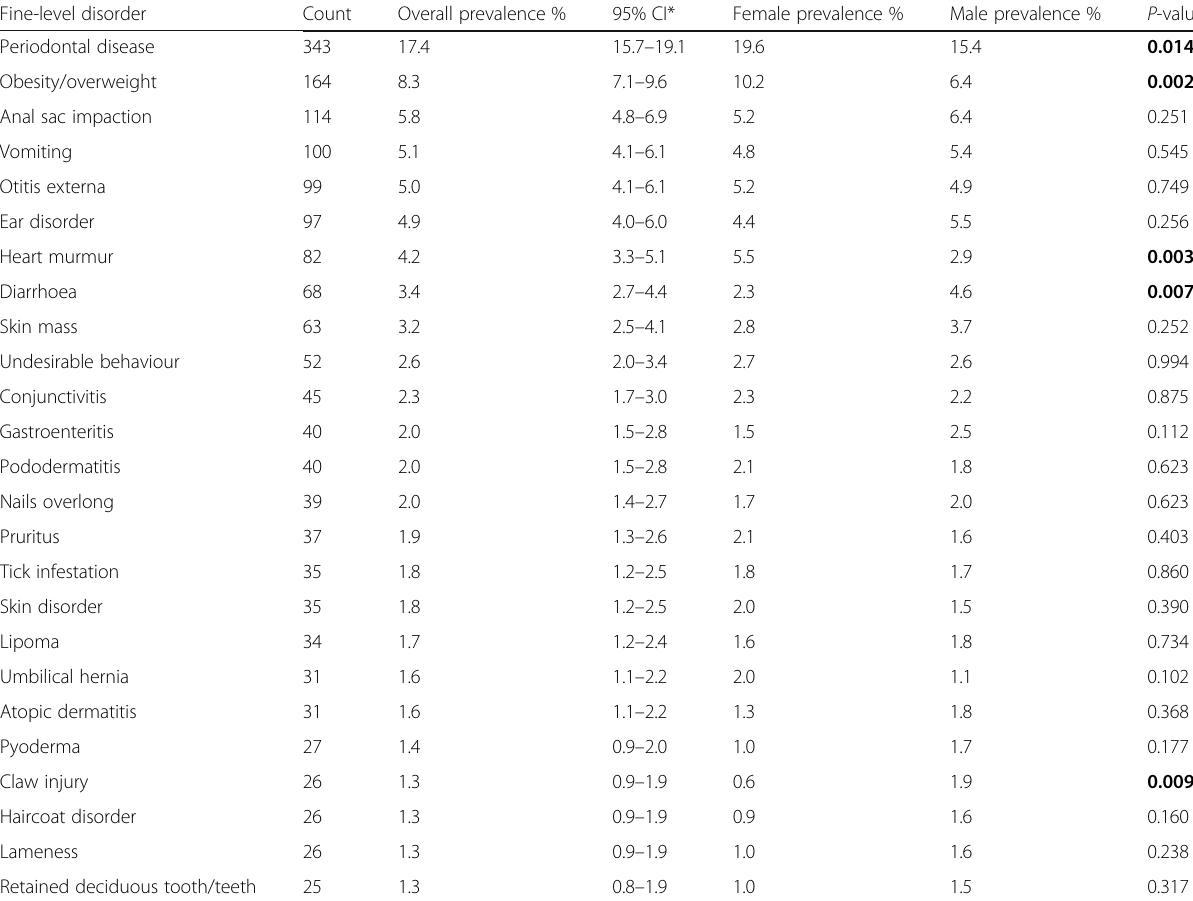
Table 3 Prevalence of the most common disorders at a fine-level of diagnostic precision recorded in Miniature Schnauzers ( n = 1972) attending UK primary-care veterinary practices participating in the VetCompass ™ Programme from January 1st, 2013